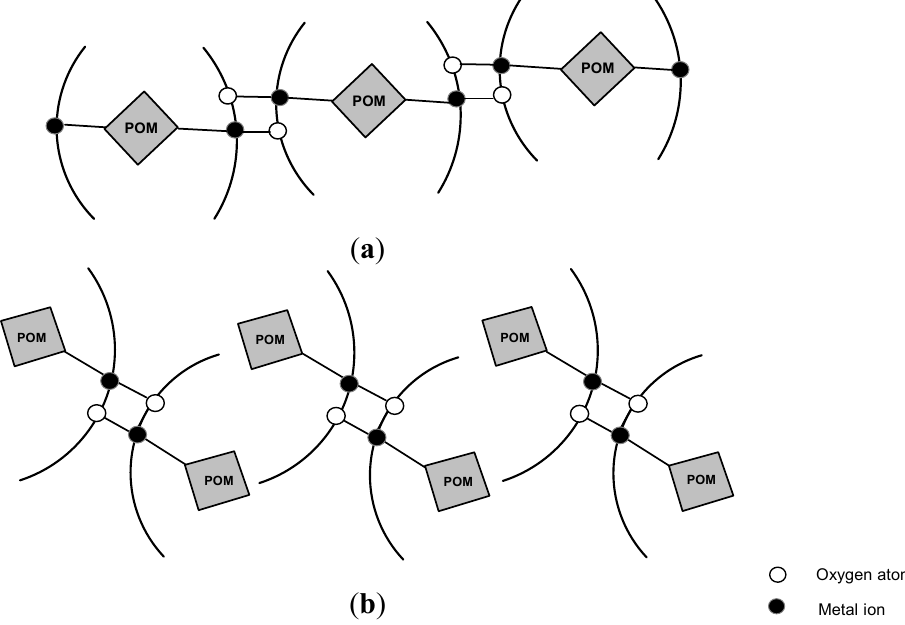
Figure 9. Schematic representation of the 1D chain structure, constructed by POMs and M-quin binuclear clusters with POM bound as ( a ) bidentate bridging ligand or ( b ) unidentate